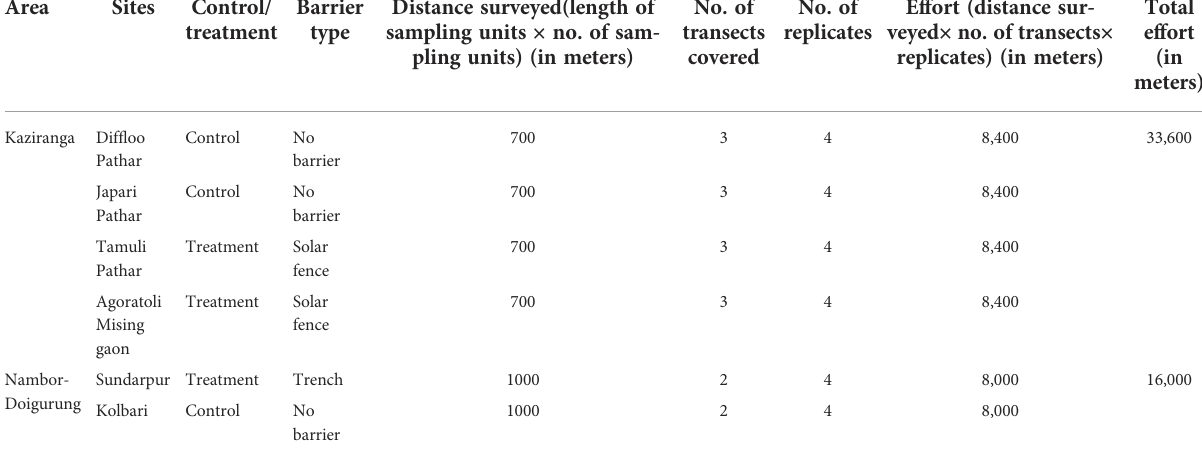
TABLE 1 List of control and treatment villages in Kaziranga and Nambor Doigurung areas of the Golaghat district depicting efforts done in each during the survey period. Area Sites Control/ Barrier Distance surveyed(length of No. type sampling units × no. of sam- pling units) (in meters)